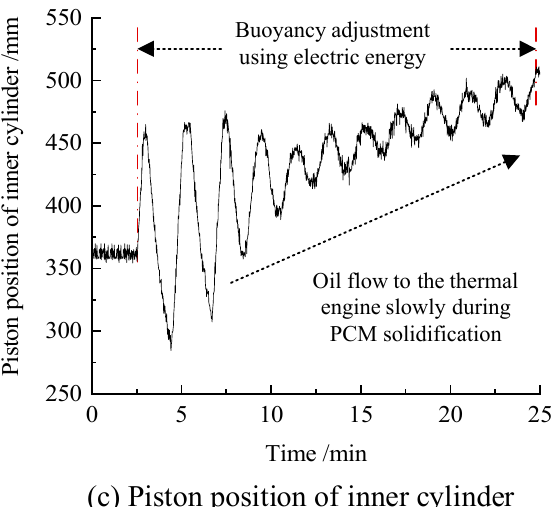
Figure 9. Depth control state curve of the profiler.